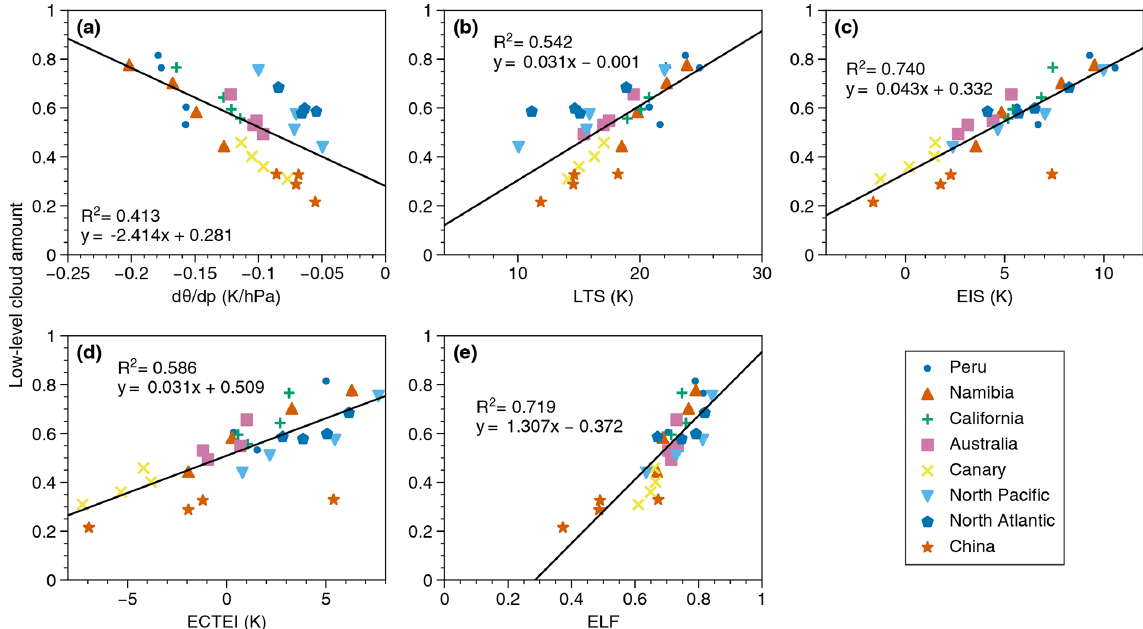
Figure 5. The relationship between low-level cloud amount and (a) minimum d θ/ d p below 750hPa, (b) lower tropospheric stability (LTS), (c) estimated inversion strength (EIS), (d) estimated cloud-top entrainment index (ECTEI) and (e) estimated low-level cloud fraction (ELF) over stratiform cloud regions, including Peru (20 ◦ S–5 ◦ N, 80–90 ◦ W), Namibia (10–30 ◦ S, 0–15 ◦ E), California (15–30 ◦ N, 110–150 ◦ W), Australia (15–35 ◦ S, 90–110 ◦ E), the Canary Islands (15–25 ◦ N, 25–35 ◦ W), the North Pacific (40–50 ◦ N, 170–180 ◦ E), the North Atlantic (50–60 ◦ N, 35–45 ◦ W) and China (20–30 ◦ N, 105–120 ◦ E), which are selected based on Klein and Hartmann (1993). The data sets are from ERA-Interim reanalysis covering the period from 2013 to 2017. The four points in each region denote the average for different seasons. Linear regression lines and the corresponding fraction of variance ( R 2 ) explained by the equation are shown at the top of each